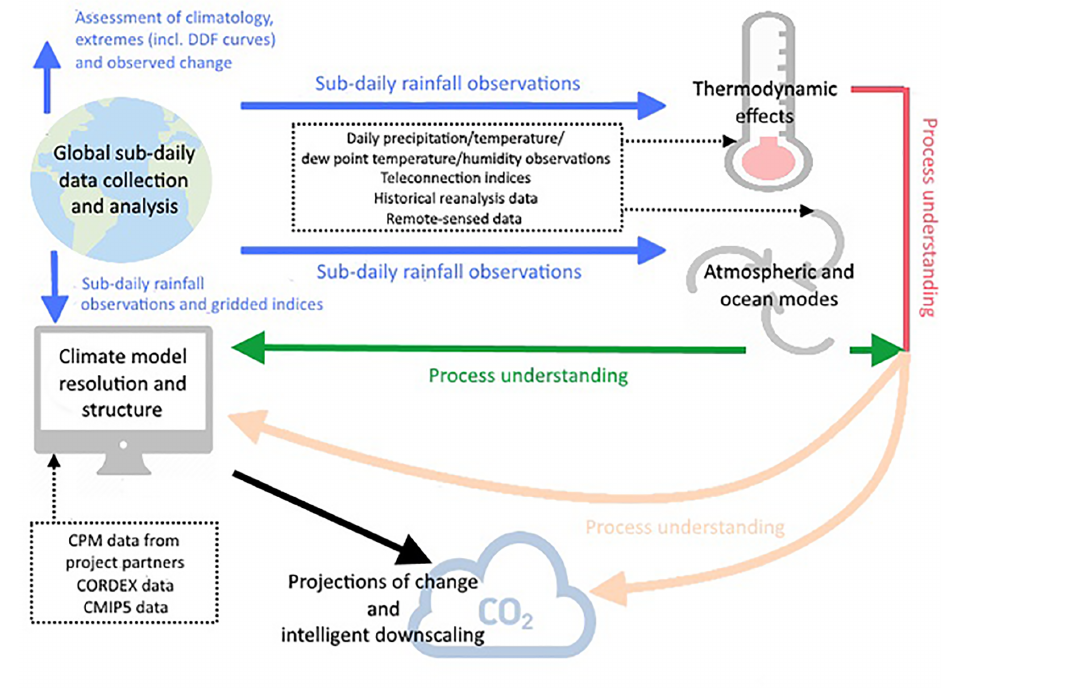
Figure 1. INTENSE project research themes, information flows and outcomes. The collection of in situ sub-daily rain gauge data represents a core project activity (blue arrows). Thermodynamic and atmospheric/ocean processes are considered independently (red and green arrows) but also in an integrated manner (yellow arrows). These data and knowledge will be used to evaluate model simulations of extreme rainfall across different timescales and locations. Model outputs will then be used for the development of process-based downscaling methods and provide guidance on the use of projections (black arrow). Data in dashed boxes denotes externally produced data used in the project.